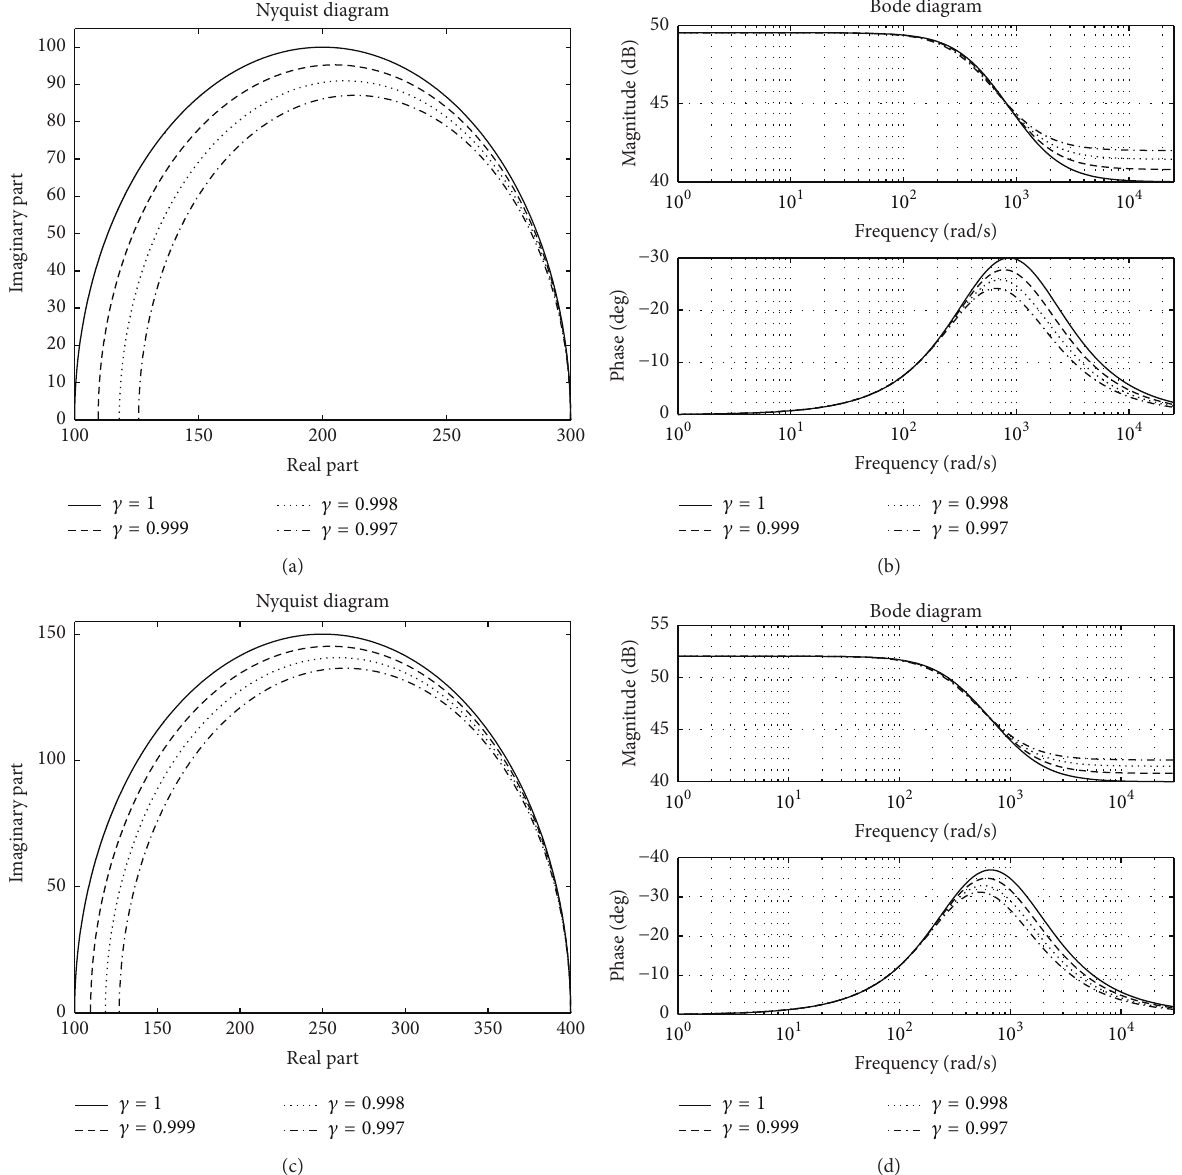
Figure 3: Nyquist and Bode diagram for the model of polarizable electrode, Caputo-Fabrizio derivative approach, in (a) and (b): 𝑅 𝑠 = 100 Ω , = 200 Ω for 𝛾 = 1 , 𝛾 = 0.999 , 𝛾 = 0.998 , and 𝛾 = 0.997 ; for (c) and (d), 𝑅 𝐶 = 1 −4 F, and 𝑅 𝑝 𝛾 = 0.999 , 𝛾 = 0.998 , and 𝛾 = 0.997